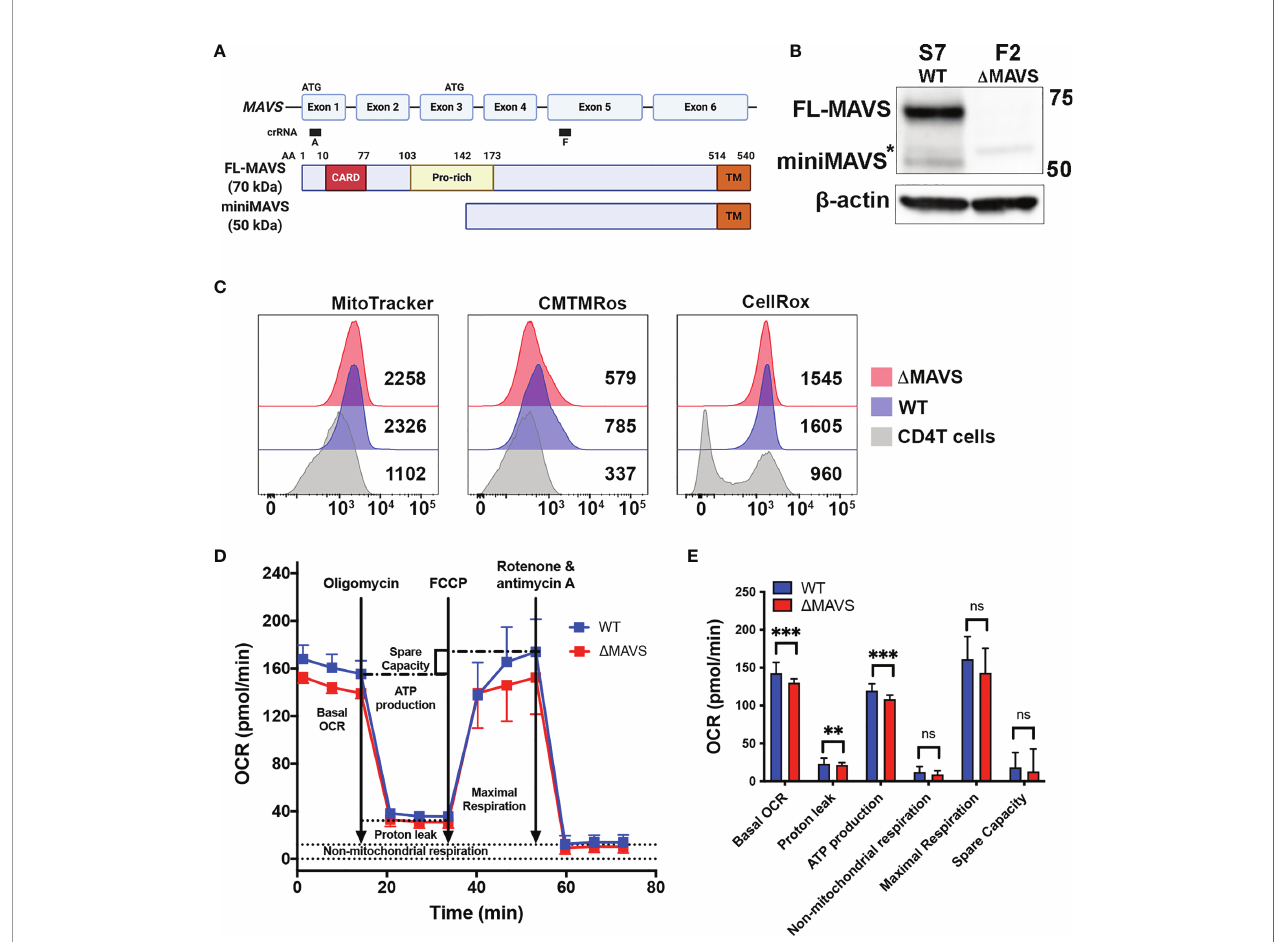
FIGURE 3 | Characterization of J-Lat D MAVS. (A) Exon and protein map of MAVS and CRISPR guide RNA targeting regions. Created with BioRender.com (B) Western blot of selected CRISPR clones generated with a scrambled guide RNA (S7-WT) or generated targeting exon 5 of MAVS (F2- D MAVS). *non-speci fi c band. (C) Analysis of mitochondrial content (MitoTracker), mitochondrial membrane potential (CMTMRos) and reactive oxygen species content (CellROX) in the WT and D MAVS J-Lat clone and compare with that of primary CD4 T cells. (D, E) Analysis of mitochondrial function or Oxygen Consumption Rate (OCR) in WT and D MAVS J-Lat clone using the Agilent Seahorse XF Cell Mito Stress Test. Data are represented as mean ± SD of 21 measurements. Mann-Whitney test was used to calculate p-values between WT and D MAVS J-Lat clone. (**p < 0.01; ***p < 0.001; ns, not signi fi